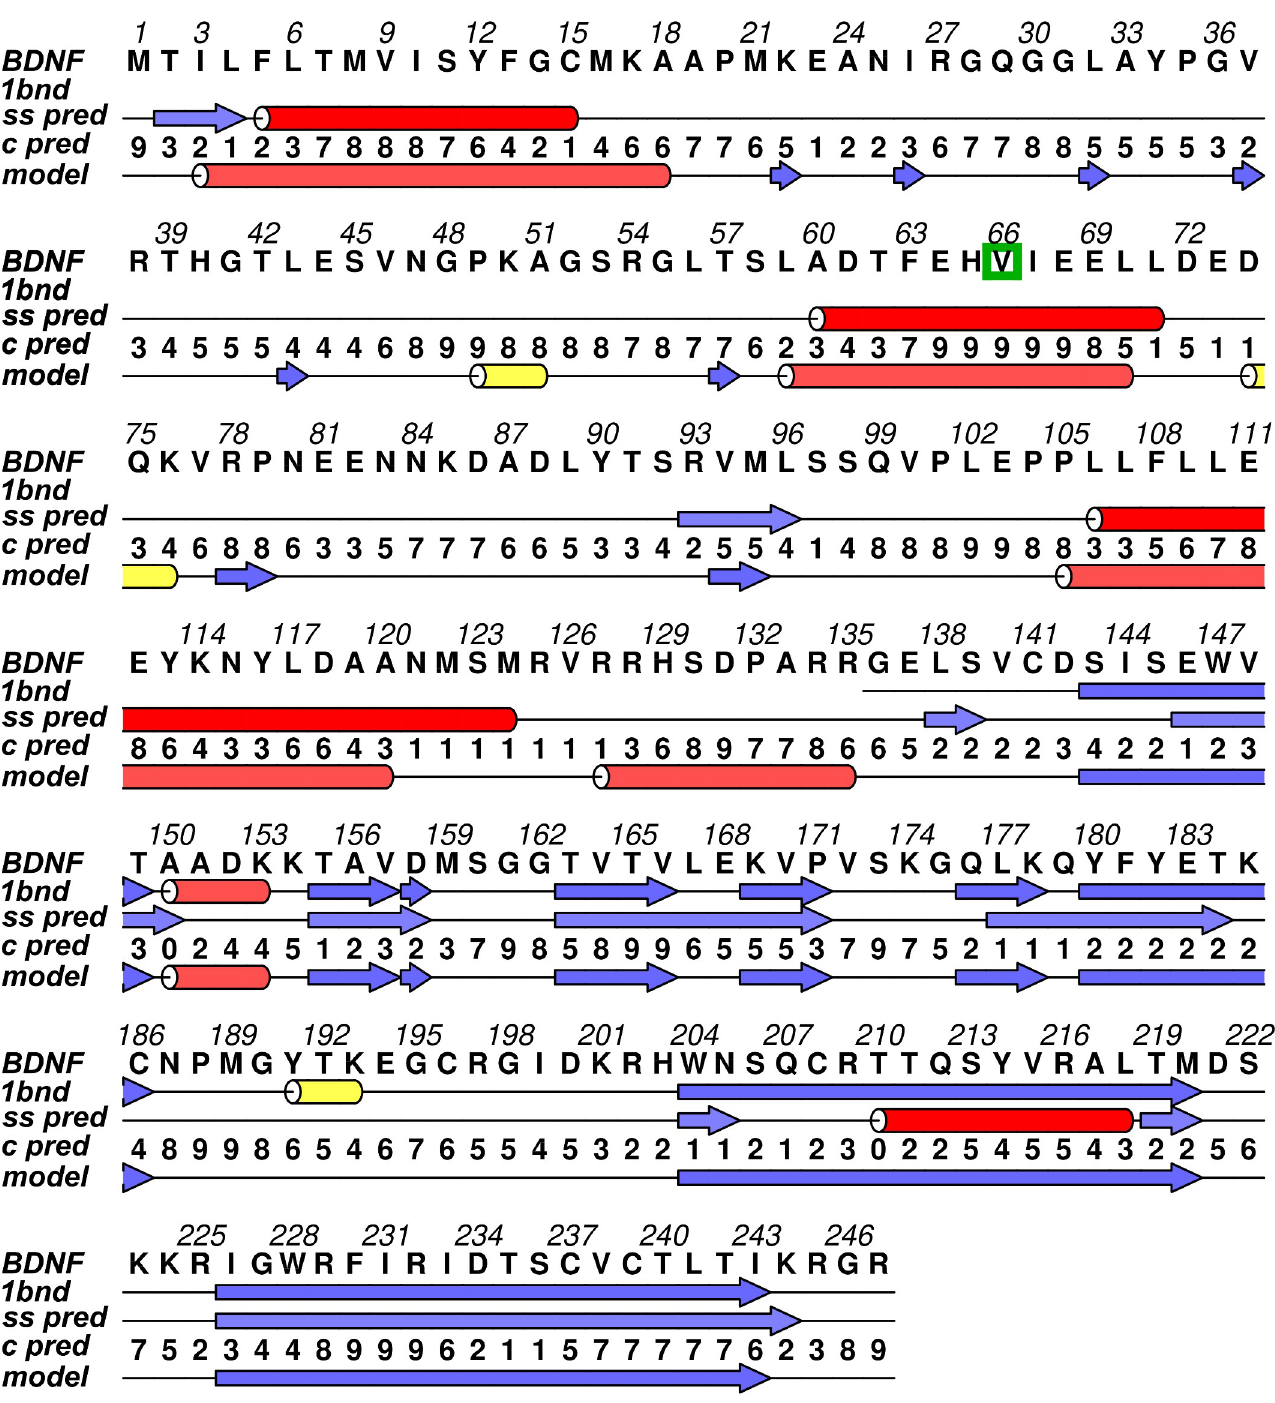
Fig 5. Secondary structure comparison between the theoretical model of BDNF, the CONCORD prediction, and the 1BND experimental fragment. The amino acid sequence of BDNF wild type is shown in the first line of the alignment, followed by the secondary structure of the 1BND fragment, the consensus secondary structure prediction by CONCORD (ss pred), the CONCORD confidence score (c pred), and the secondary structure of the theoretical model of BDNF. Red cylinders represent the α -helices, yellow cylinders represent the 3–10 helices, and blue arrows represent the β -strands.